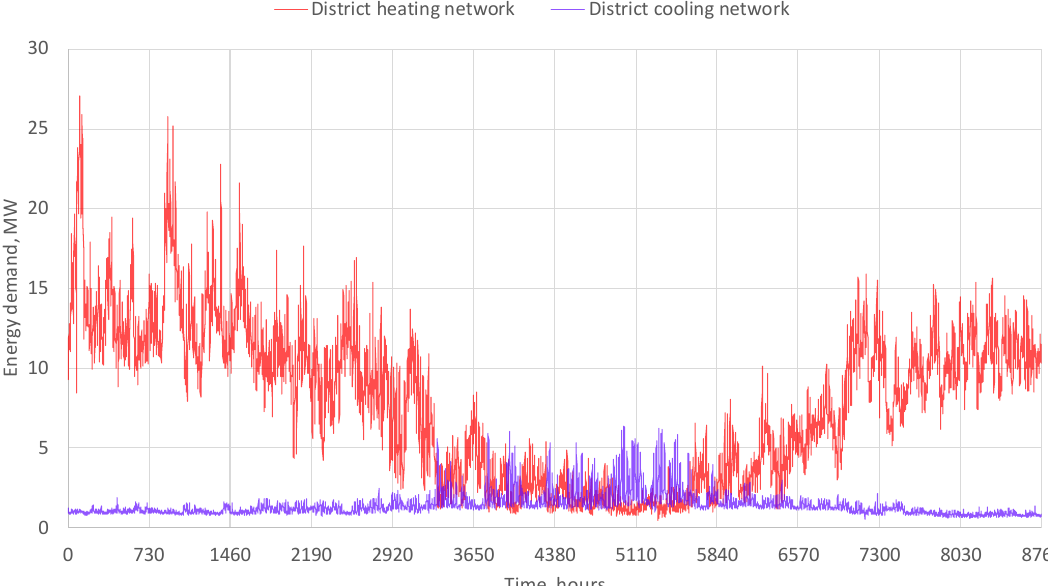
Figure 2. Annual energy demand of Kupittaa DH–DC networks.